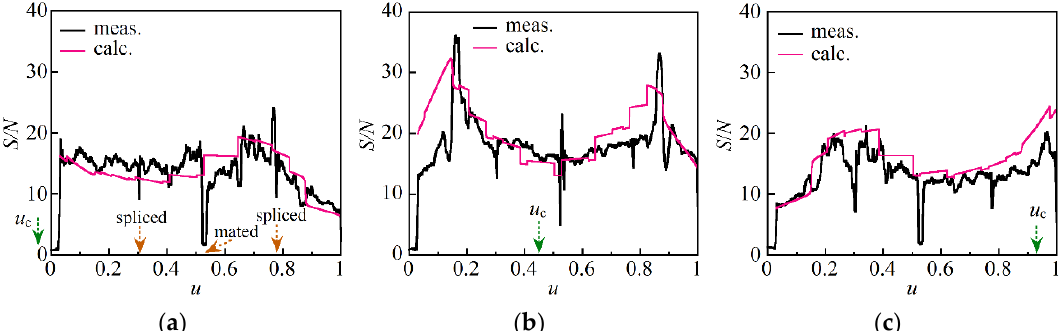
Figure 6. Distributions of S/N along a 1.35 m long optical fiber that were measured and calculated at ( a ) u c = −0.042, ( b ) u c = 0.45 and ( c ) u c = 0.93, where the DFB LD was driven with current source A whose power spectral density is shown in Figure 5a. The scale of the horizontal axis is normalized in such a way that the output end of the fiber under test was unity. The rapid changes of S/N observed around u = 0.31, 0.53 and 0.78 were caused by fusion splicing and mating of the pieces of the optical fiber.